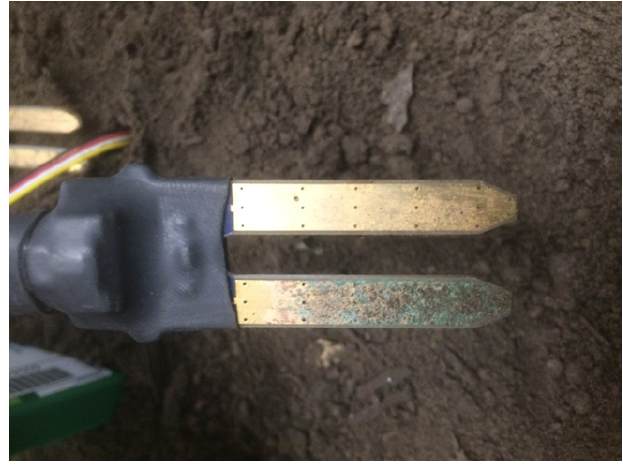
Figure 15. A corroded soil